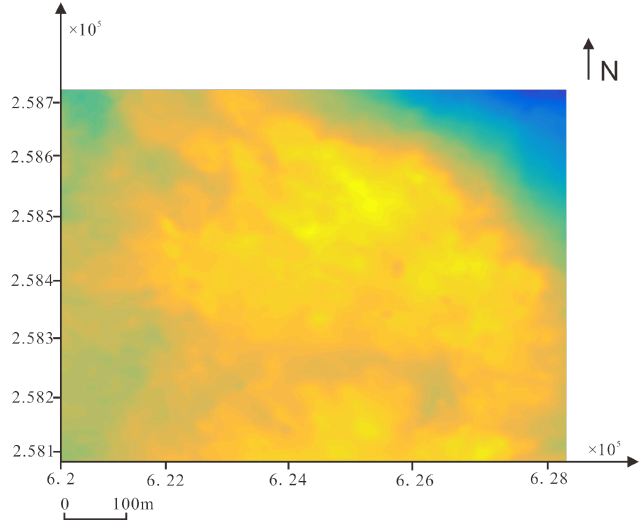
Figure 5. DEM clipping image.